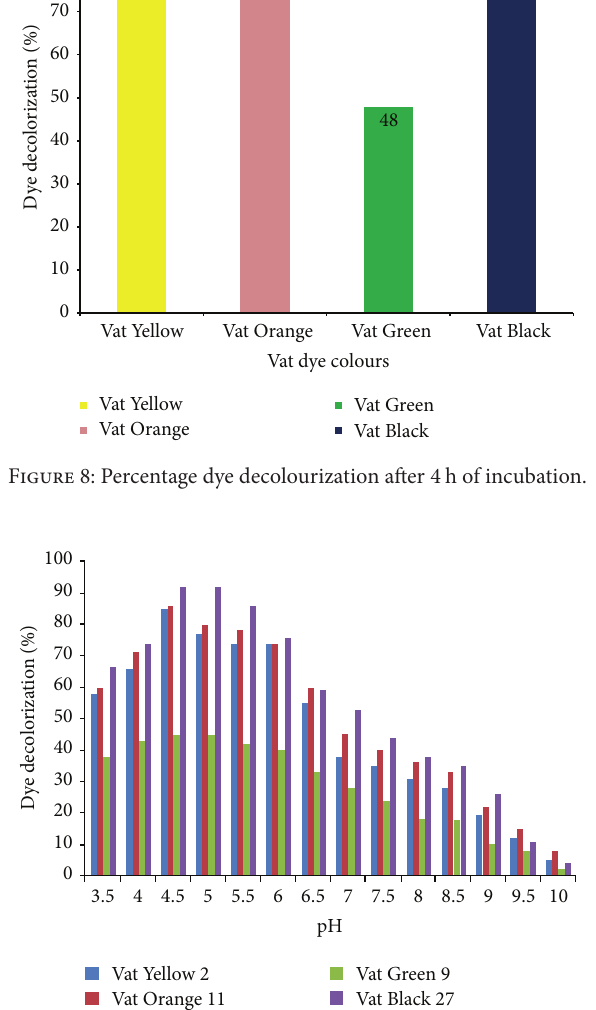
Figure 9: Dye decolourization as a function of